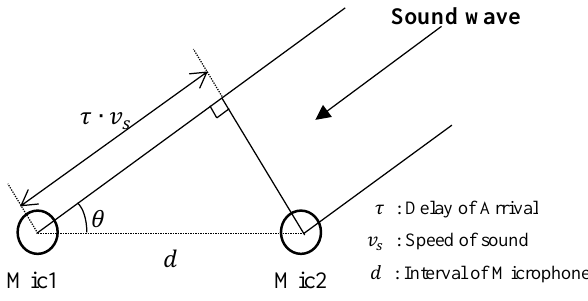
Figure 5. Basic geometry of a microphone pair.